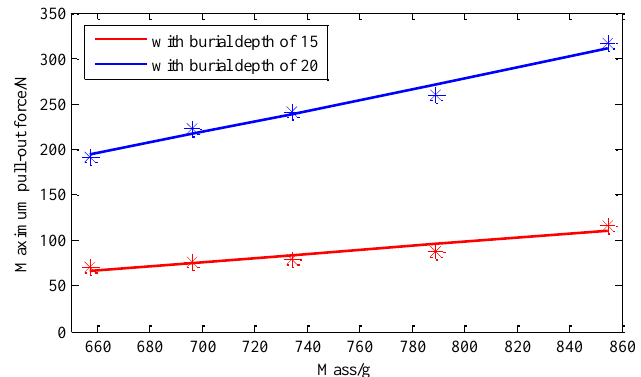
Figure 13. Curve fitting of the maximum pull-out force at different buried depths.